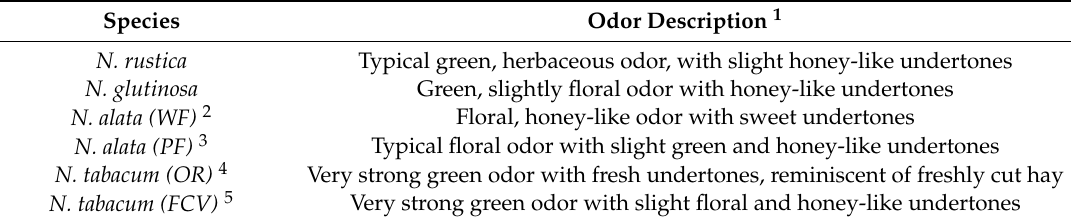
Table 2. Olfactory profiles of Nicotiana flower